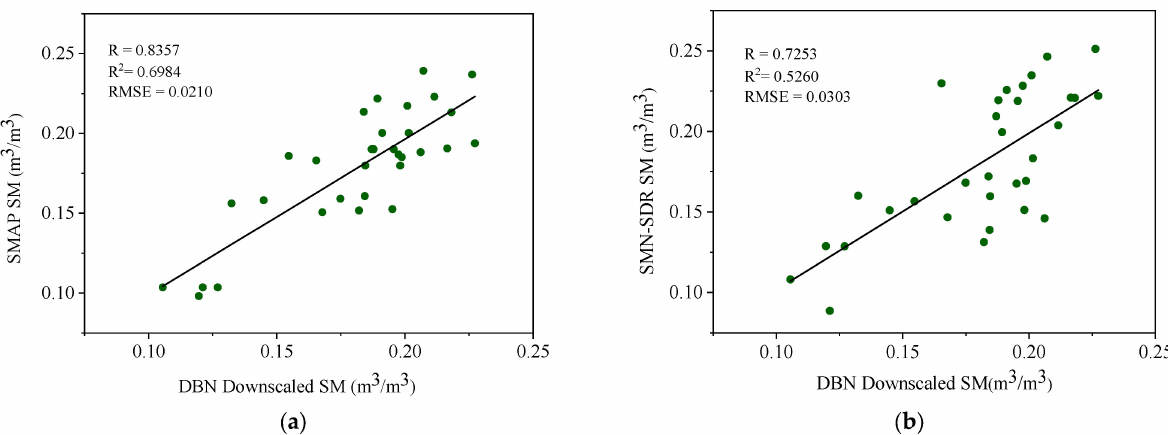
Figure 6. Scatter plot of SM from DBN downscaling versus original SMAP SM data ( a ) and SMN-SDR in situ measurements ( b